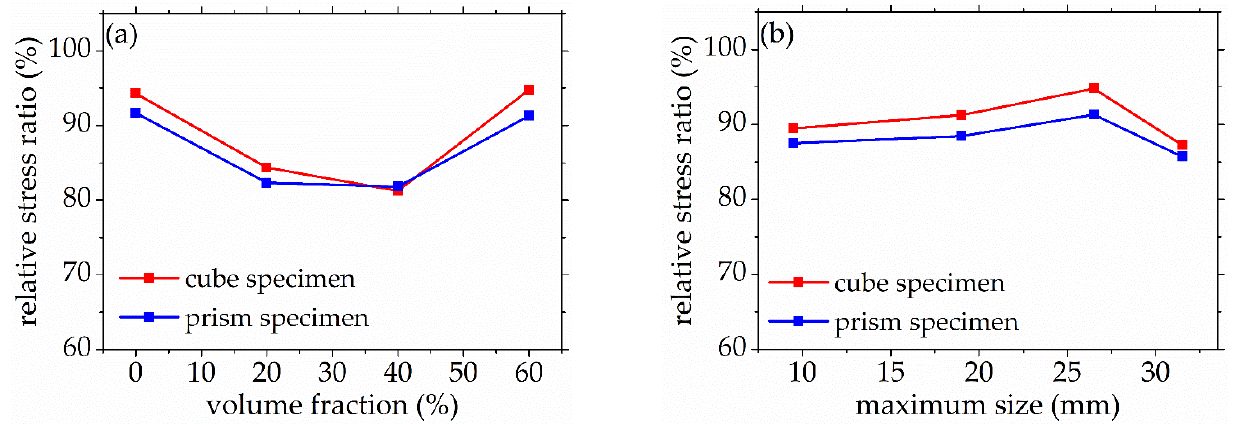
Figure 13. The relative stress ratio of concrete with different mix proportions at the peak point of damage stage II, ( a ) volume fraction, ( b ) maximum size.